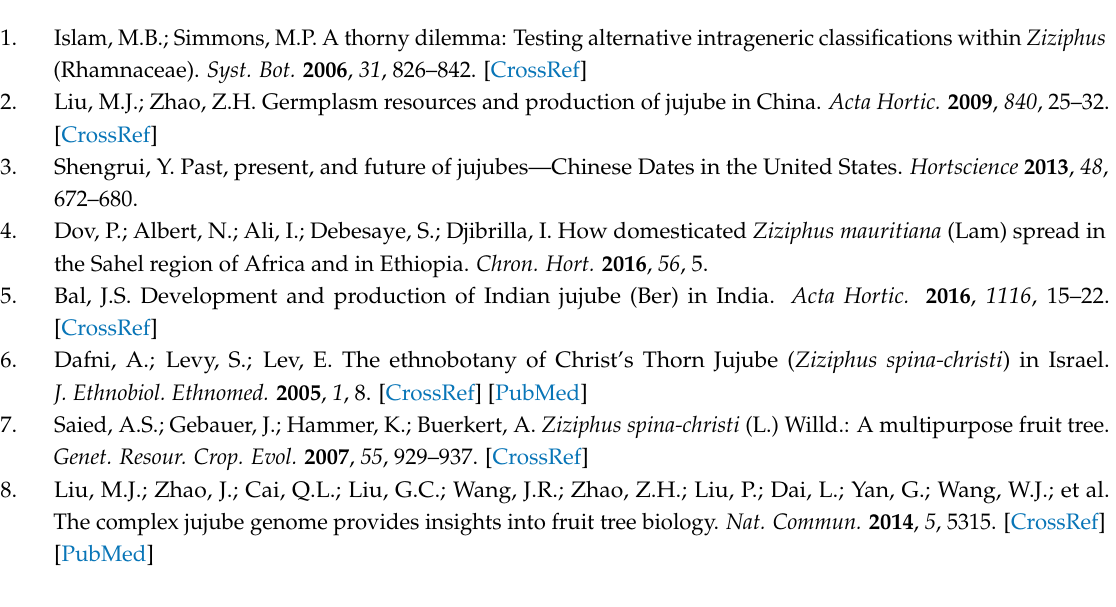
Table S1 Chloroplast genome assembly, size and features, Table S2 PCR primer sets for chloroplast genome sequence validation, Table S3 Species and gene lists used for phylogenetic analyses, Table S4 Repeats ( ≥ 30 bp) identified in four Ziziphus species, Table S5 SSR position in Ziziphus chloroplast genome, Table S6 Percentage of variation sites in each region, Table S7 Nonsynonymous substitution (dN), Synonymous substitution (dS), and dN/dS ( ω ) values for individual genes or gene groups ( ω (dN, dS), Figure S1 Sequence identity plots among the four Ziziphus chloroplast genomes viewed by mVISTA, with Z. acidojujuba as the reference. Annotated genes are displayed along the top. The vertical scale represents the percent identity between 50 and 100%. Genome regions are color coded as exon, intron, and conserved non-coding